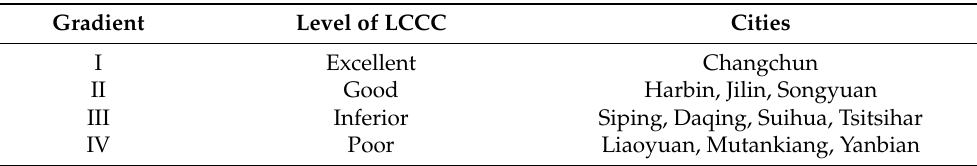
Table 4. Classification standards of the LCCC in the